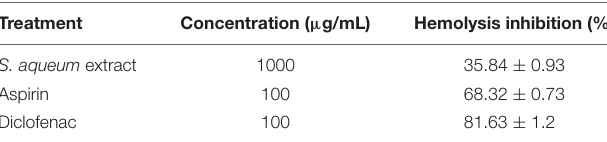
TABLE 4 | Effects of the extract, aspirin, and diclofenac on hemolysis of human erythrocyte membranes caused by hypotonic buffer.